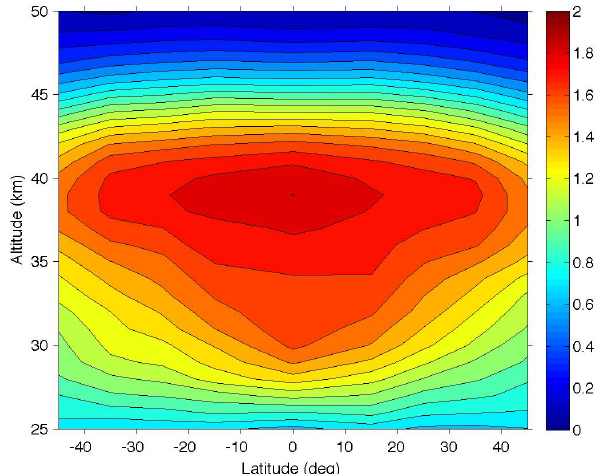
Fig. 24. An example of the NO 3 number density fitting at 40km in 40 ◦ S–50 ◦ S. Time axis unit is day. In the upper panel GOMOS measurements are shown by the blue dots and the fit by the black line. The residual is shown by red dots. All three scaled by scaled by 10 7 cm − 3 . In the lower panel the identifications are: Annual ( a 1 and b 1 contributions): dashed red, Semi-annual ( a 2 and b 2 con- tributions): dashed blue, QBO 1 ( q 1 and q 2 contributions): solid green, solar ( s ): solid magenta. The components have been scaled by a constant coefficient and given in %. The constant term itself has not been shown.